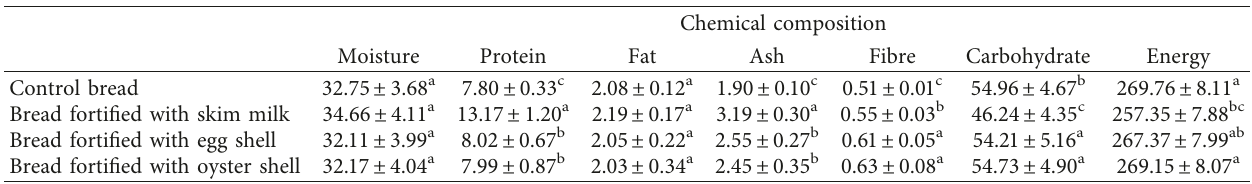
Table 5: Gross chemical composition of breads fortified with skim milk and egg shell and oyster shell powders (on dry weight bases g/100 g).